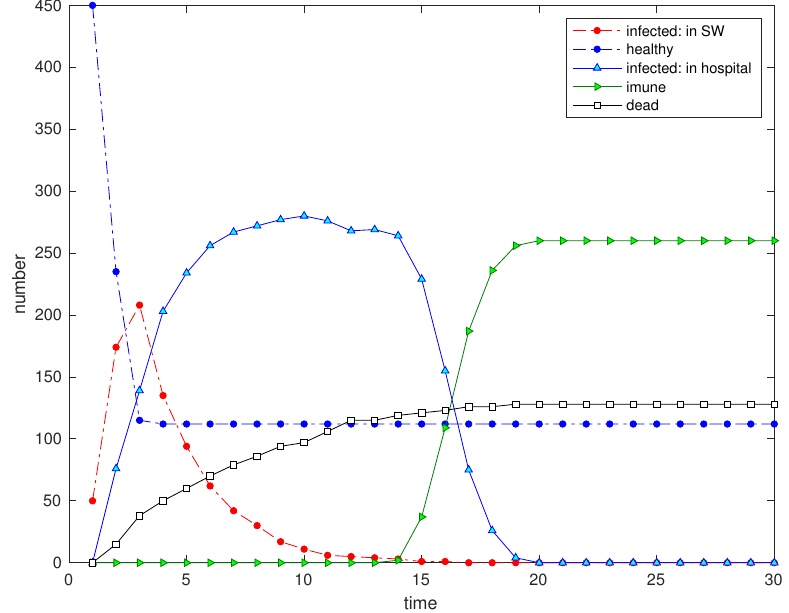
Figure 14. Scenario S 7 : Time evolution of the 5 state variables for a disturbance in the SW so that D = 0.07 for t ≤ 3, and D = 0.01 for t ≥ 4 ( N = 500, n i = 50, δ = 0.1, p 1 = 0.1, p 2 = 0.9, p 3 = 0.7, p 4 = 0.05, p 5 = 0.02, α = 2 and N h → ∞